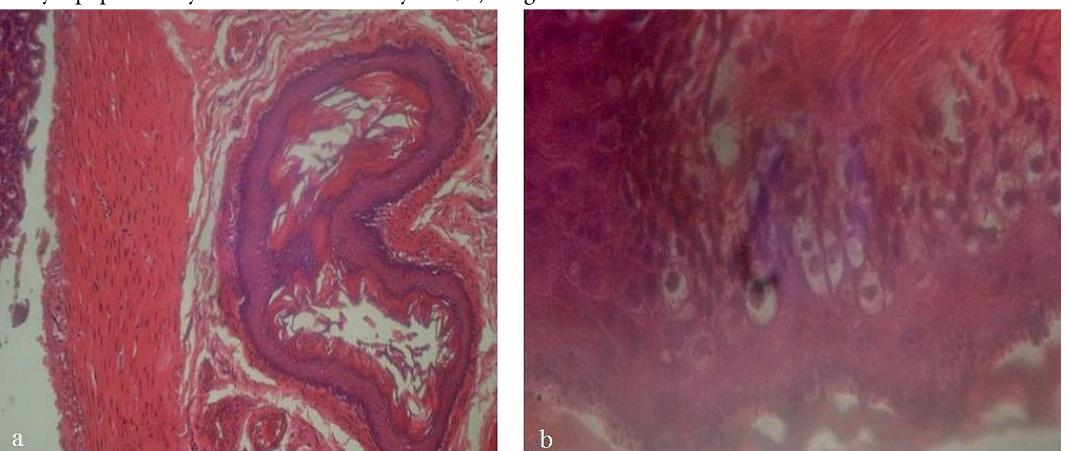
Fig. 6. Induced untreated. The Photomicrograph shows G.I.T. with lymphoid follicular hyperplasia; a) and extensive fibrous muscularis layer populated by chronic inflammatory cells; b) Mag. X 200